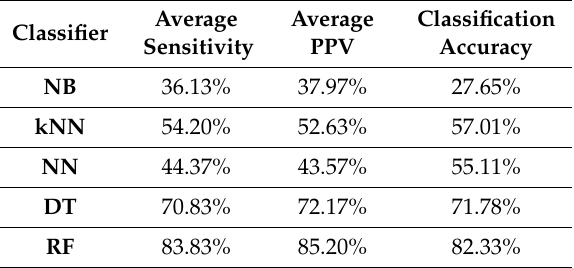
Table 4. Results for the assessment of the frailty status problem.